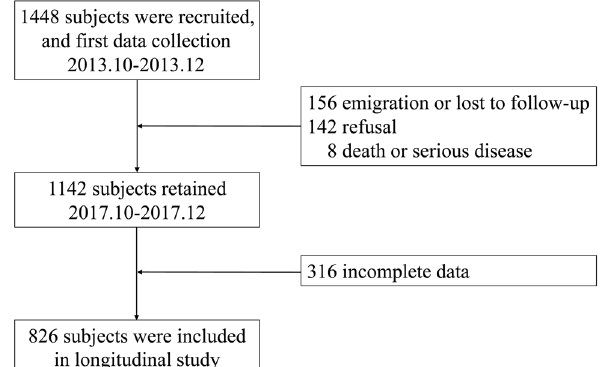
Figure 1. Flow chart of study